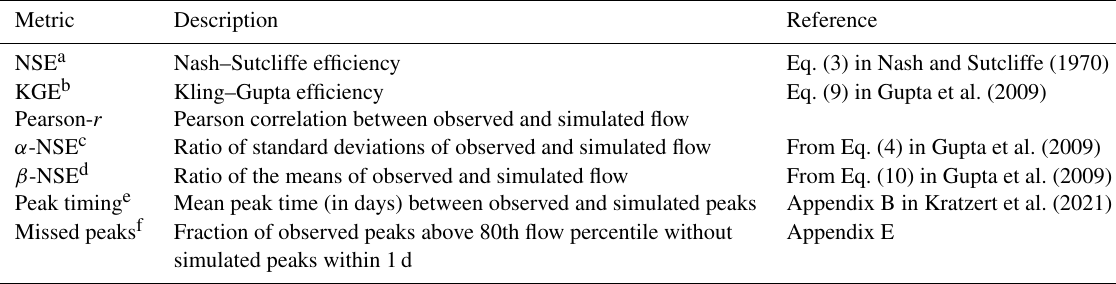
Figure 1. Median NSE (Nash–Sutcliffe efficiency) scores of AR models trained and tested with different fractions of lagged streamflow data withheld. The two subplots show the same results, but organized by the amount of lagged streamflow data withheld during training vs. during testing. Table 1. Overview of evaluation